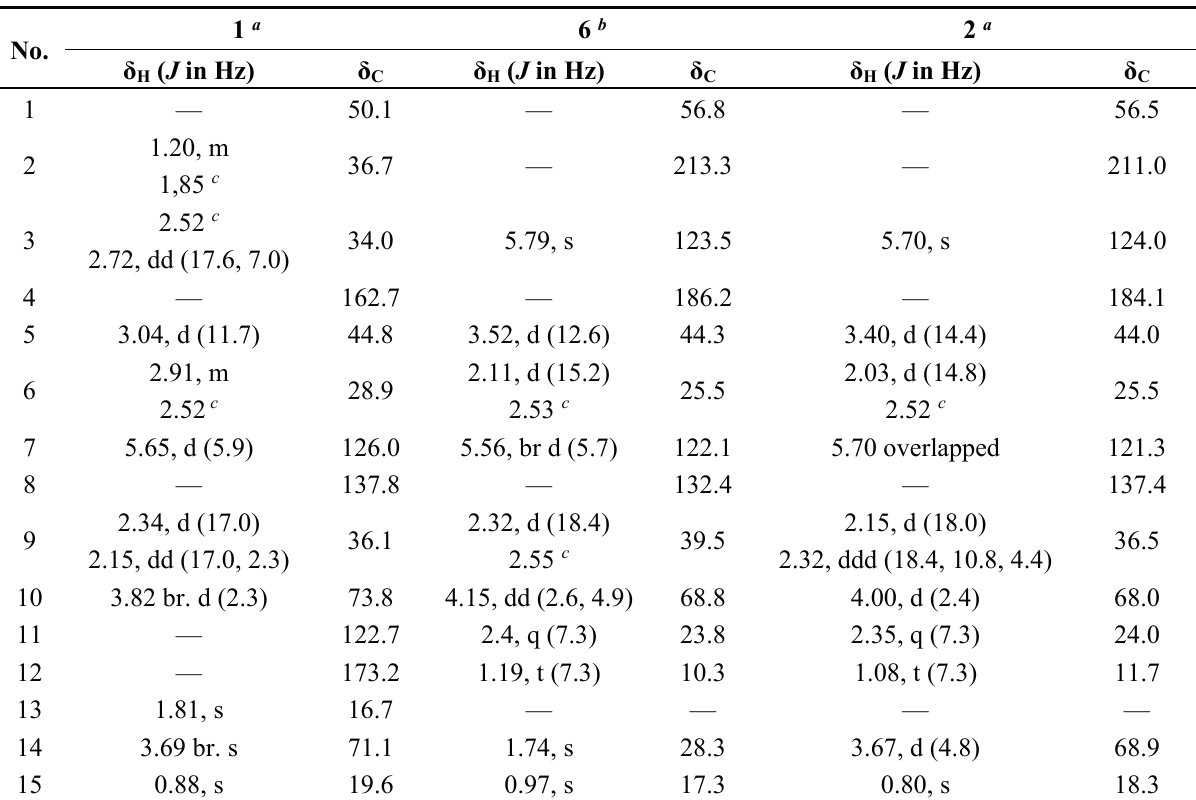
Table 1. 1 H-NMR and 13 C-NMR spectroscopic data for compounds 1 , 6 , and 2